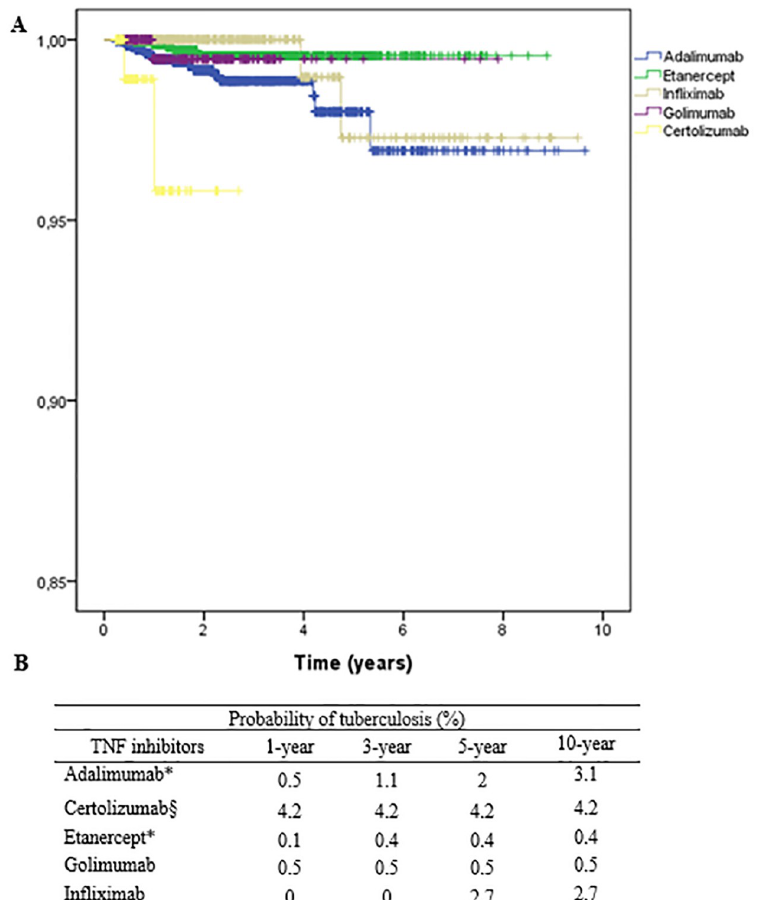
Fig 3. A: Survival curves for patients on tumor necrosis factor antagonists as a function of whether they developed tuberculosis during follow-up (log-rank p < 0.05). B: Probability of tuberculosis considering disease-free drug use in years ( � p < 0.02; § p < 0.01 for all TNF by log rank test).